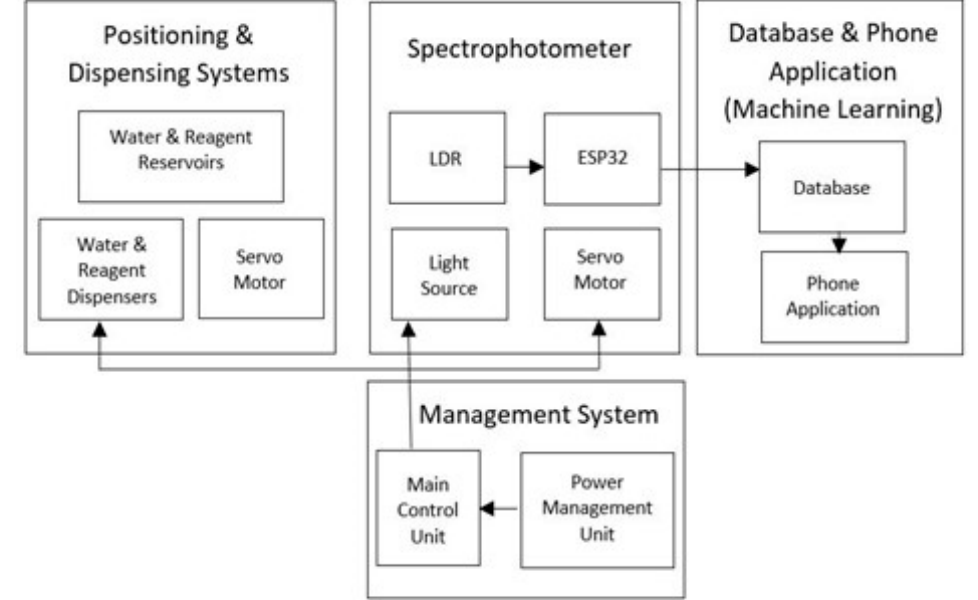
Figure 1. Functional Prototype of the NMS.